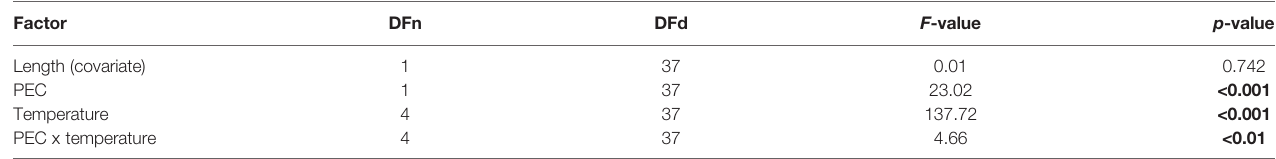
TABLE 4 | Results of two-way ANCOVA to investigate effects of pre-experimental cultivation (PEC) of parental gametophytes and experimental temperature on length growth rates of juvenile Laminaria digitata sporophytes over 2 weeks in a temperature gradient with length at day 0 as a covariate. Factor DFn DFd F -value p -value Length (covariate) 1